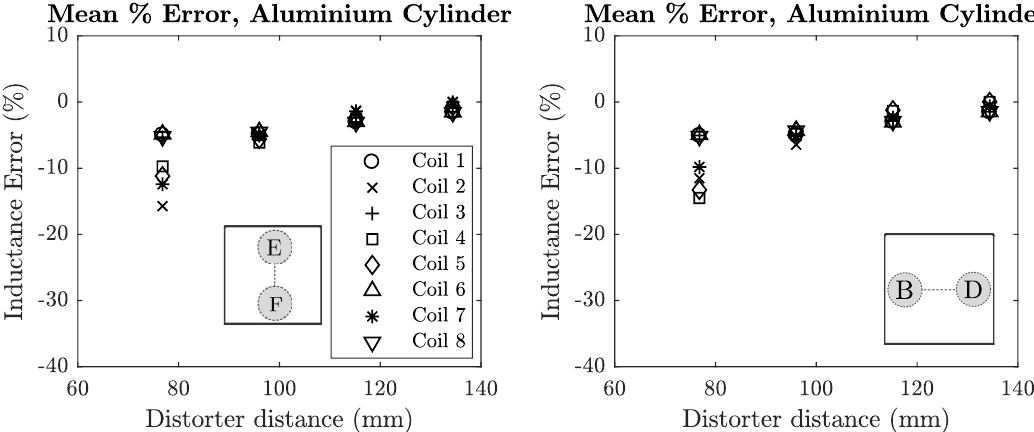
Figure A4. Mutual inductance error plots for large aluminium cylinder in locations E to F and B to D. The cylinder spans the length of the transmitter board. The highest mutual inductance errors correspond to the positions of the distorter.